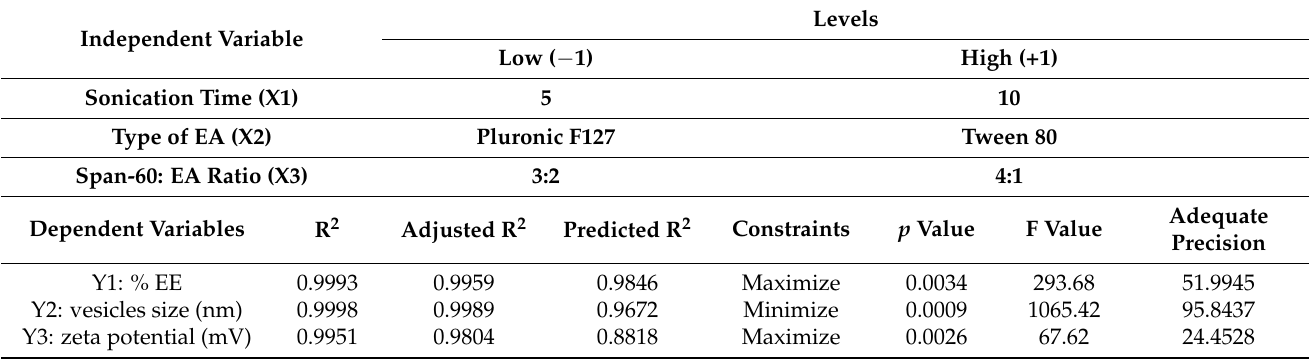
Table 1. Different variables utilized in I-optimal design for optimization of BGT-loaded